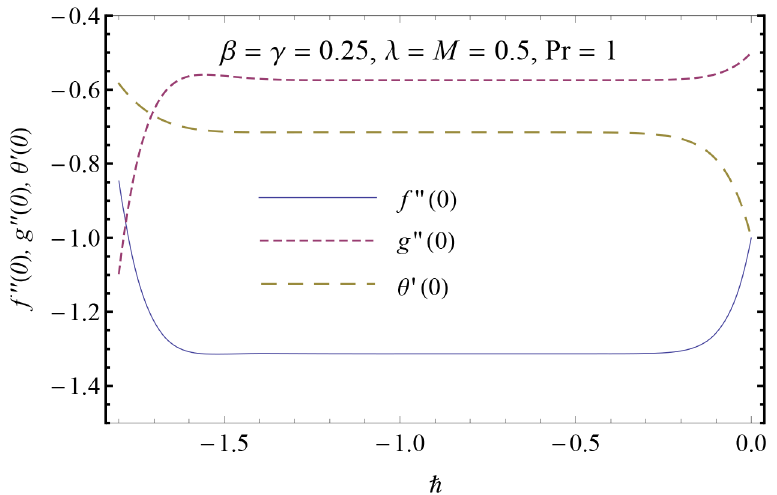
Fig 2. ℏ − curves for the functions f ( η ), g ( η ) and θ ( η ).